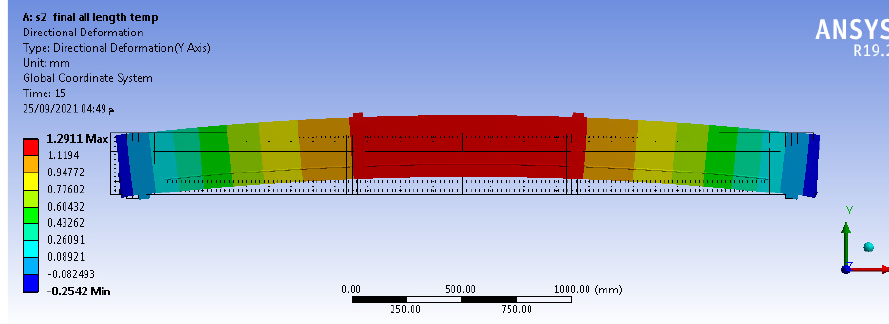
Figure 4. Pre − stressing process of specimen S2.